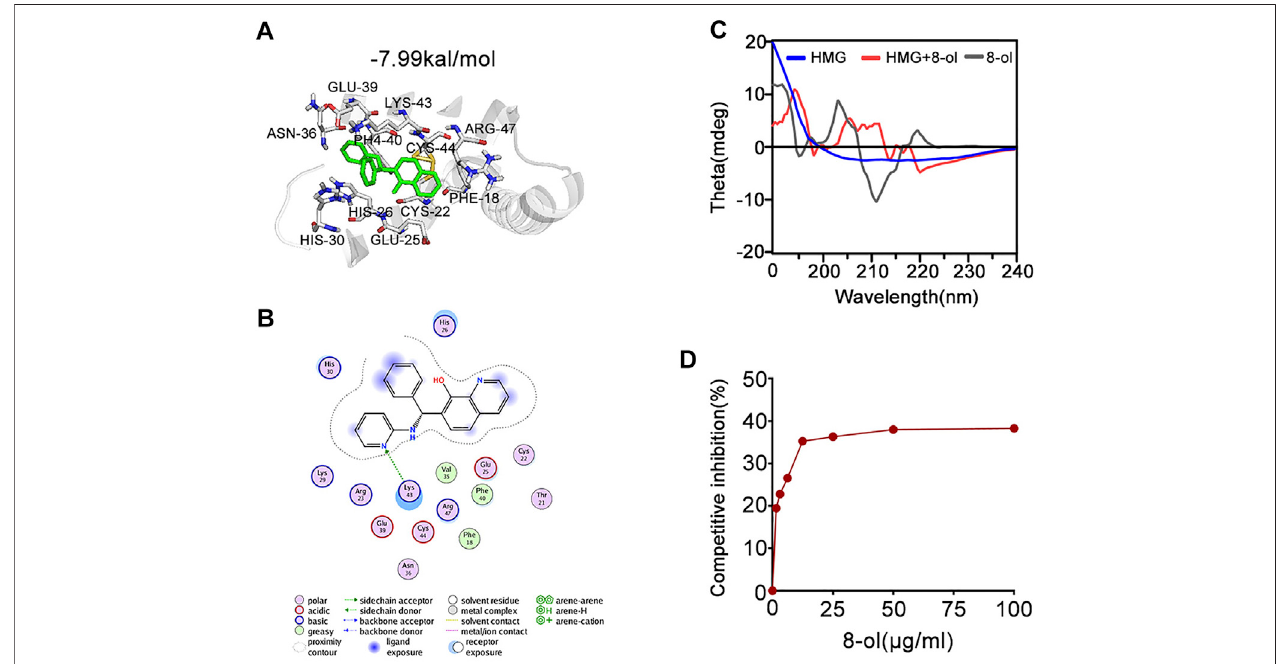
FIGURE 5 | 8-ol targets HMGB1 and changes the secondary conformation and disturbs the binding with LPS. (A) 3D binding mode diagrams between HMGB1 andthechemical7-PMQ-8-ol.Theproteinisshowninthecartoonandcoloredingray,andthechemicaliscoloredingreen.Thekeyaminoacidresidueswereshownas sticks.Dockingscoreis − 7.99 kcal/mol. (B) 2Dbindingmodeillustratesthekeyaminoacidresiduesintheligand – proteincomplexes. (C) CDspectraofthechemical8-ol between HMGB1. (D) The LPS-binding capacity of HMGB1 incubated with different concentrations of the chemical